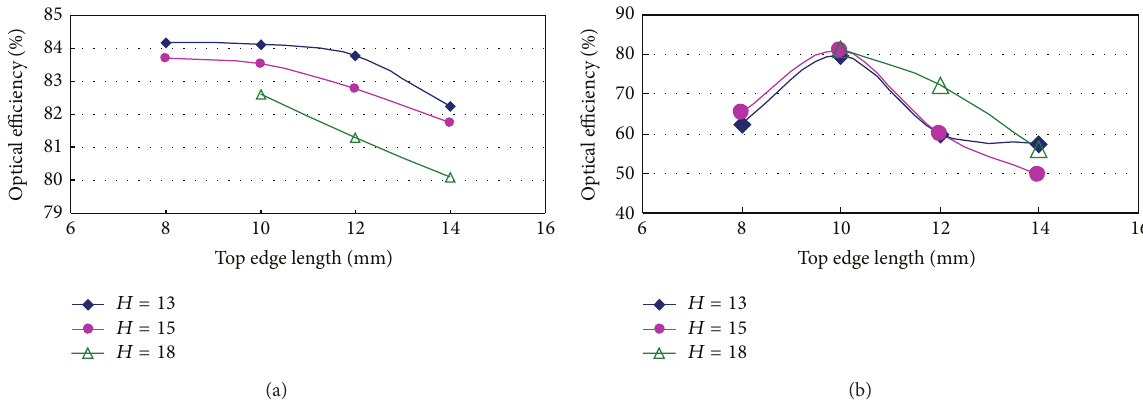
Figure 9: Effects of refractive pyramid SOE parameters (Phase II) on the optical efficiency: (a) incidence angle = 0 ∘ (normal incidence) and (b) incidence angle = 1 ∘ .